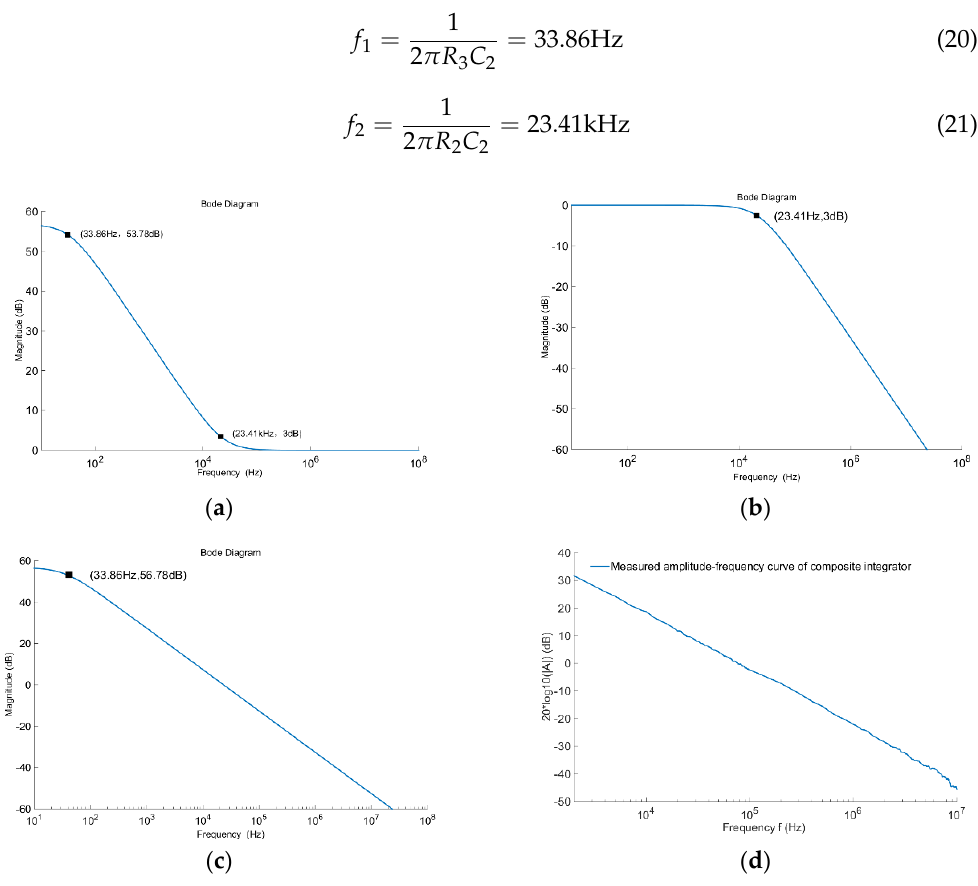
Figure 11. Amplitude-frequency curve . ( a ) Simulation amplitude-frequency curve of the RC integrator; ( b ) Simulation amplitude-frequency curve of the passive integrator; ( c ) Simulation amplitude-frequency curve of the hybrid integrator; ( d ) Measure amplitude-frequency curve of the hybrid integrator.